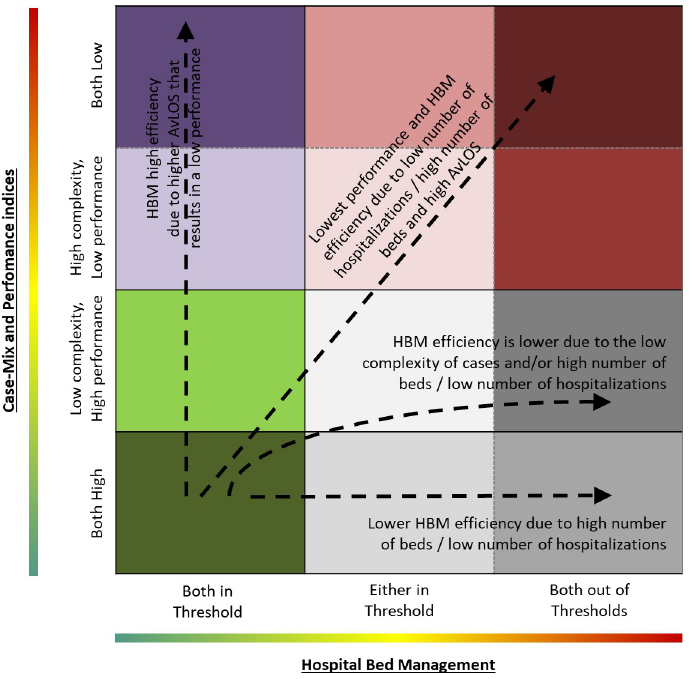
Fig 1. Overall clustering considering the hospital bed management (x-axis) and the case-mix and performance indicators